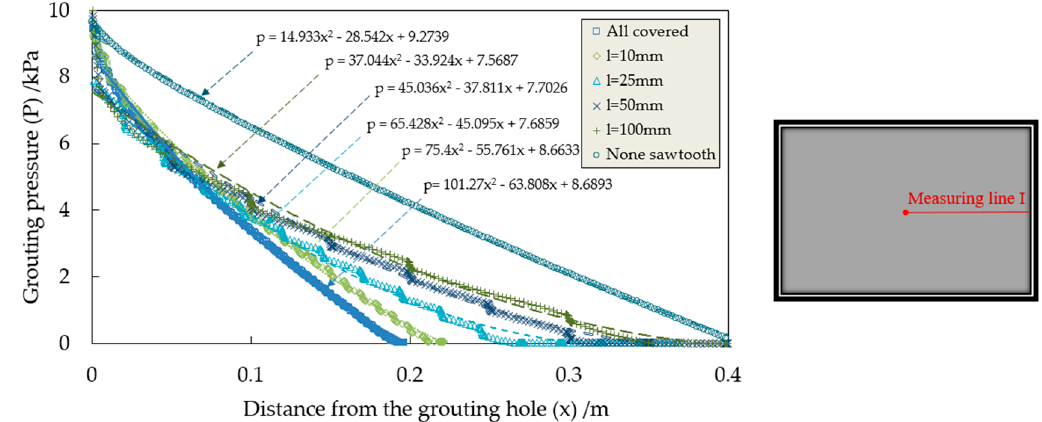
Figure 22. The grouting pressure distribution along the x+ direction under different conditions.